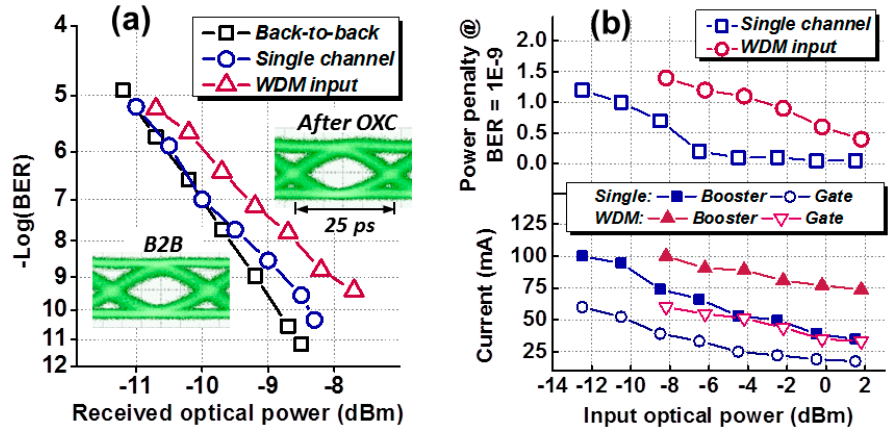
Figure 13. ( a ) BER curves and ( b ) the dynamic range with adjusted SOA current for 40 Gb/s traffic.